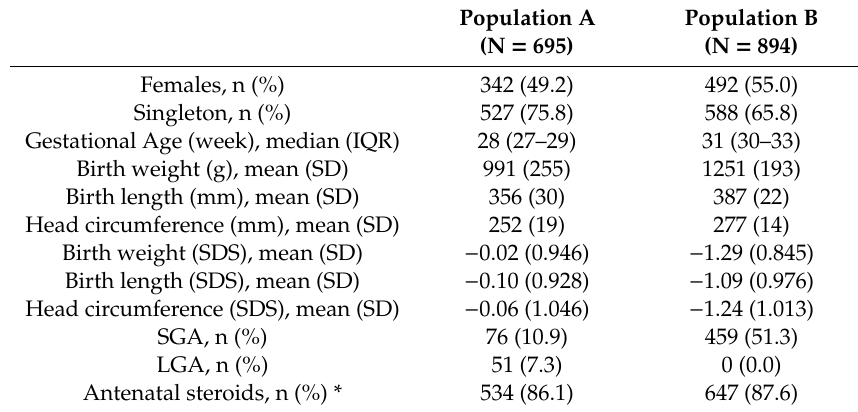
Table 1. General characteristics of babies by population.